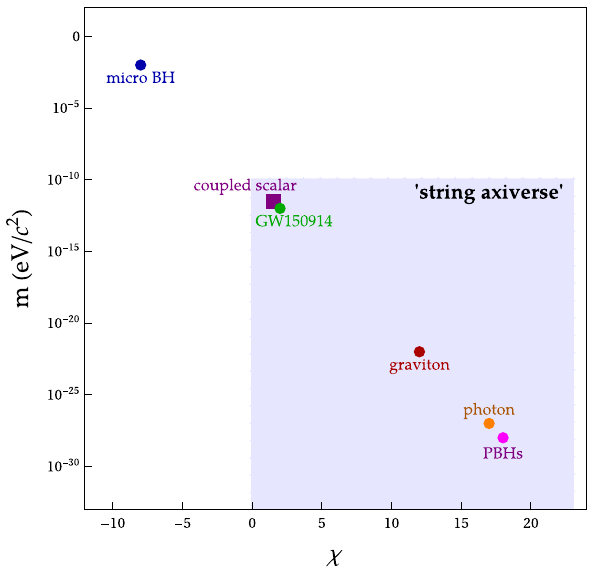
Fig. 5 For a sense of the scales probed by QNFs for M μ ∼ 1, we illustrate the magnitudes of m and χ of Eqs. (3.55) and (3.56) discussed in the text. We include the upper bounds for the photon mass [123] and thegraviton[69],aswellasthelowermassboundformassiveprimordial blackholes[130].Wenotethatparticlesofthesemagnitudescorrespond to those of the “string axiverse”scenarios